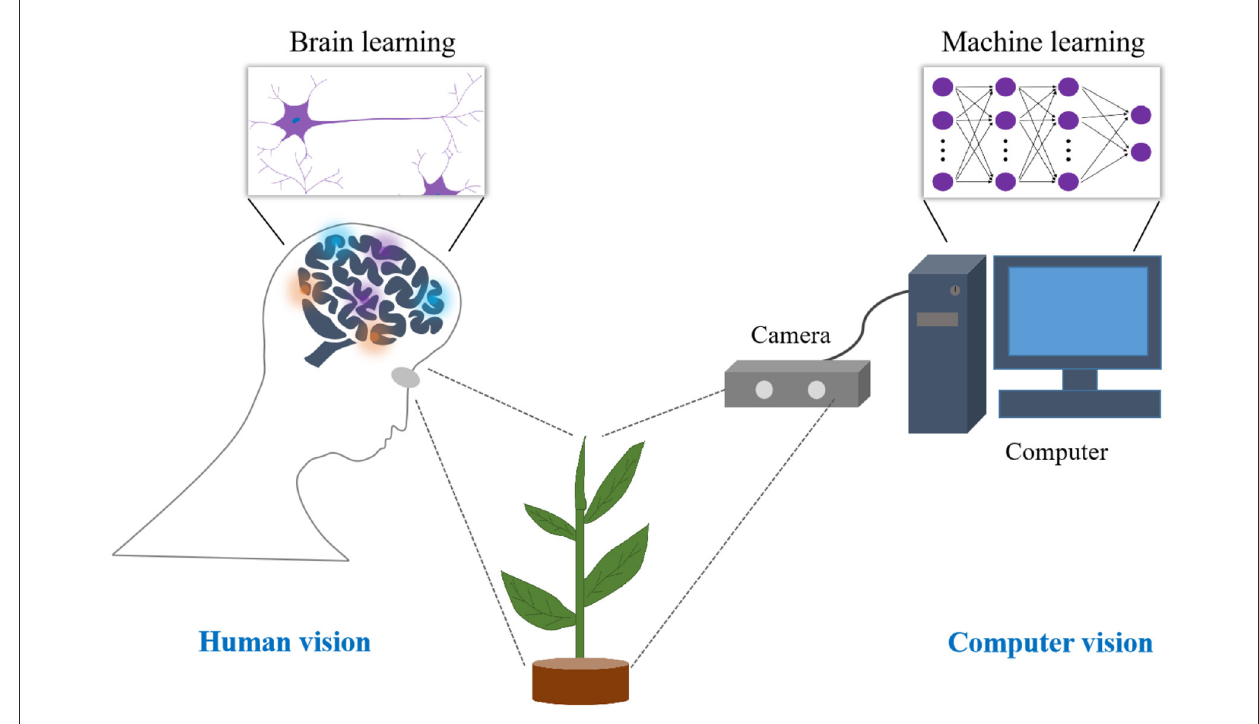
FIGURE3 Comparing computer vision with human